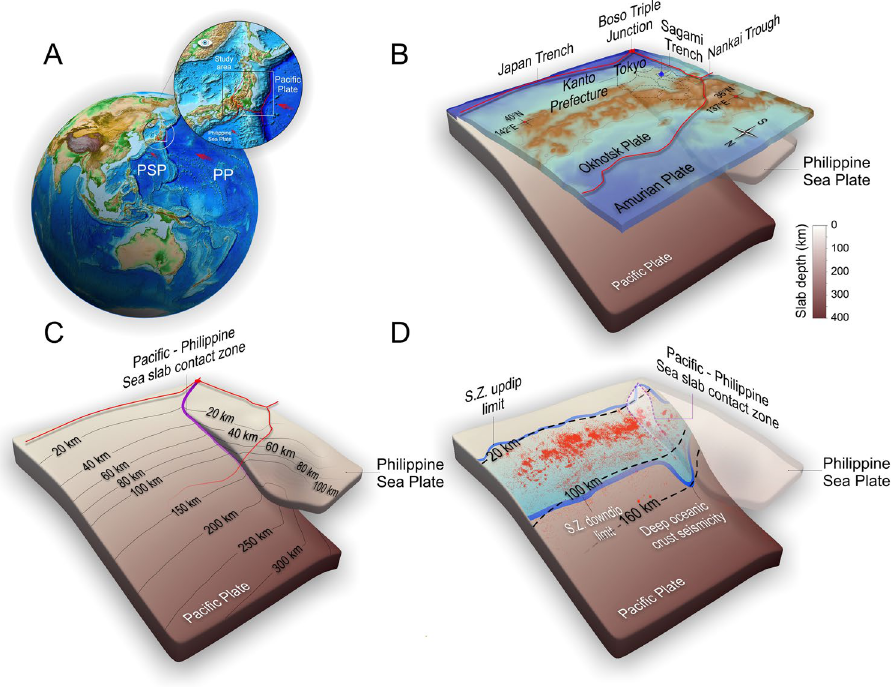
Figure 1. Location of the study area where the Philippine Sea plate subducts on top of the Pacific plate. ( A ) Color-shaded global bathymetry and topography map (ETOPO1 Global Relief Model dataset 45 ). The figure was created with the open source software ParaView (http://www.paraview.org) version 5.0.1, licensed under the CC BY 4.0 license (https://creativecommons.org/licenses/by/4.0/). The study area is marked by the white rectangle. ( B ) 3-D view of the study area. Red curves mark the main plate boundary. All 3-D models are visualized from a northwest to southeast viewing angle. ( C ) Geometry of the Pacific and Philippine Sea slabs corresponding to the study area. ( D ) Pacific oceanic crust seismicity (from the unified hypocenter data catalogue (1997.10-2015.2) with magnitude no less than 2.0 from Japan Meteorological Agency) plotted on top of the slab (red dots). The Philippine Sea plate is shown as semitransparent surface. Dark blue rubber bands mark the updip and downdip limit of the crustal seismicity. PP- Pacific Plate, PSP – Philippine Sea